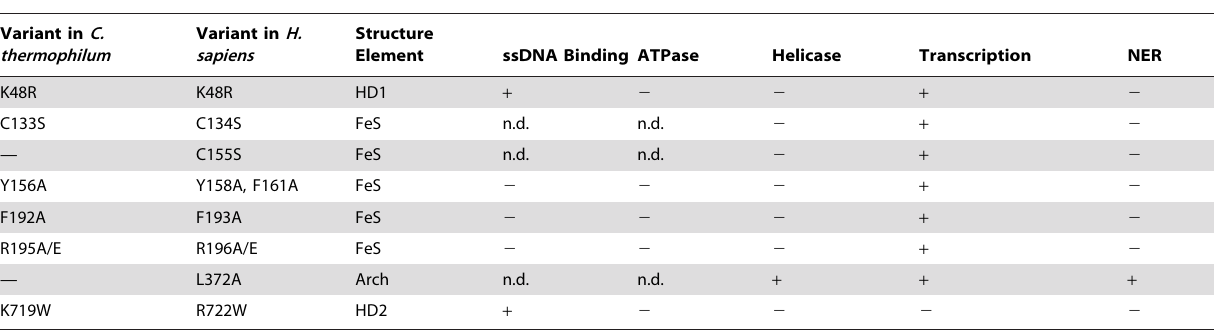
Table 1. List of ctXPD and hsXPD variants, their location, and properties.